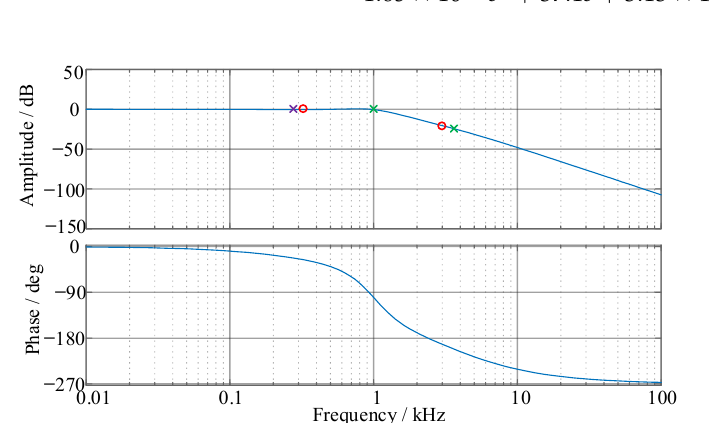
Figure 10. Bode plot of transfer function of current closed loop.